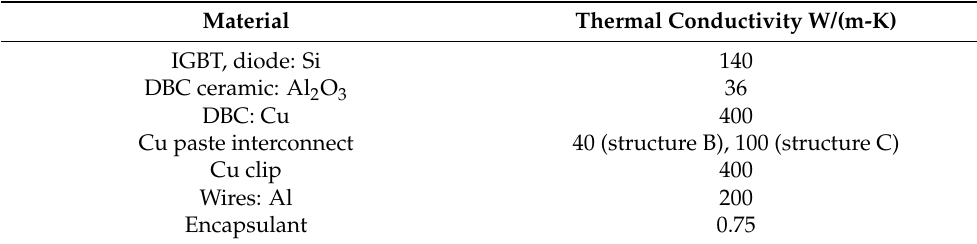
Table 1. Thermal conductivities of the materials used for